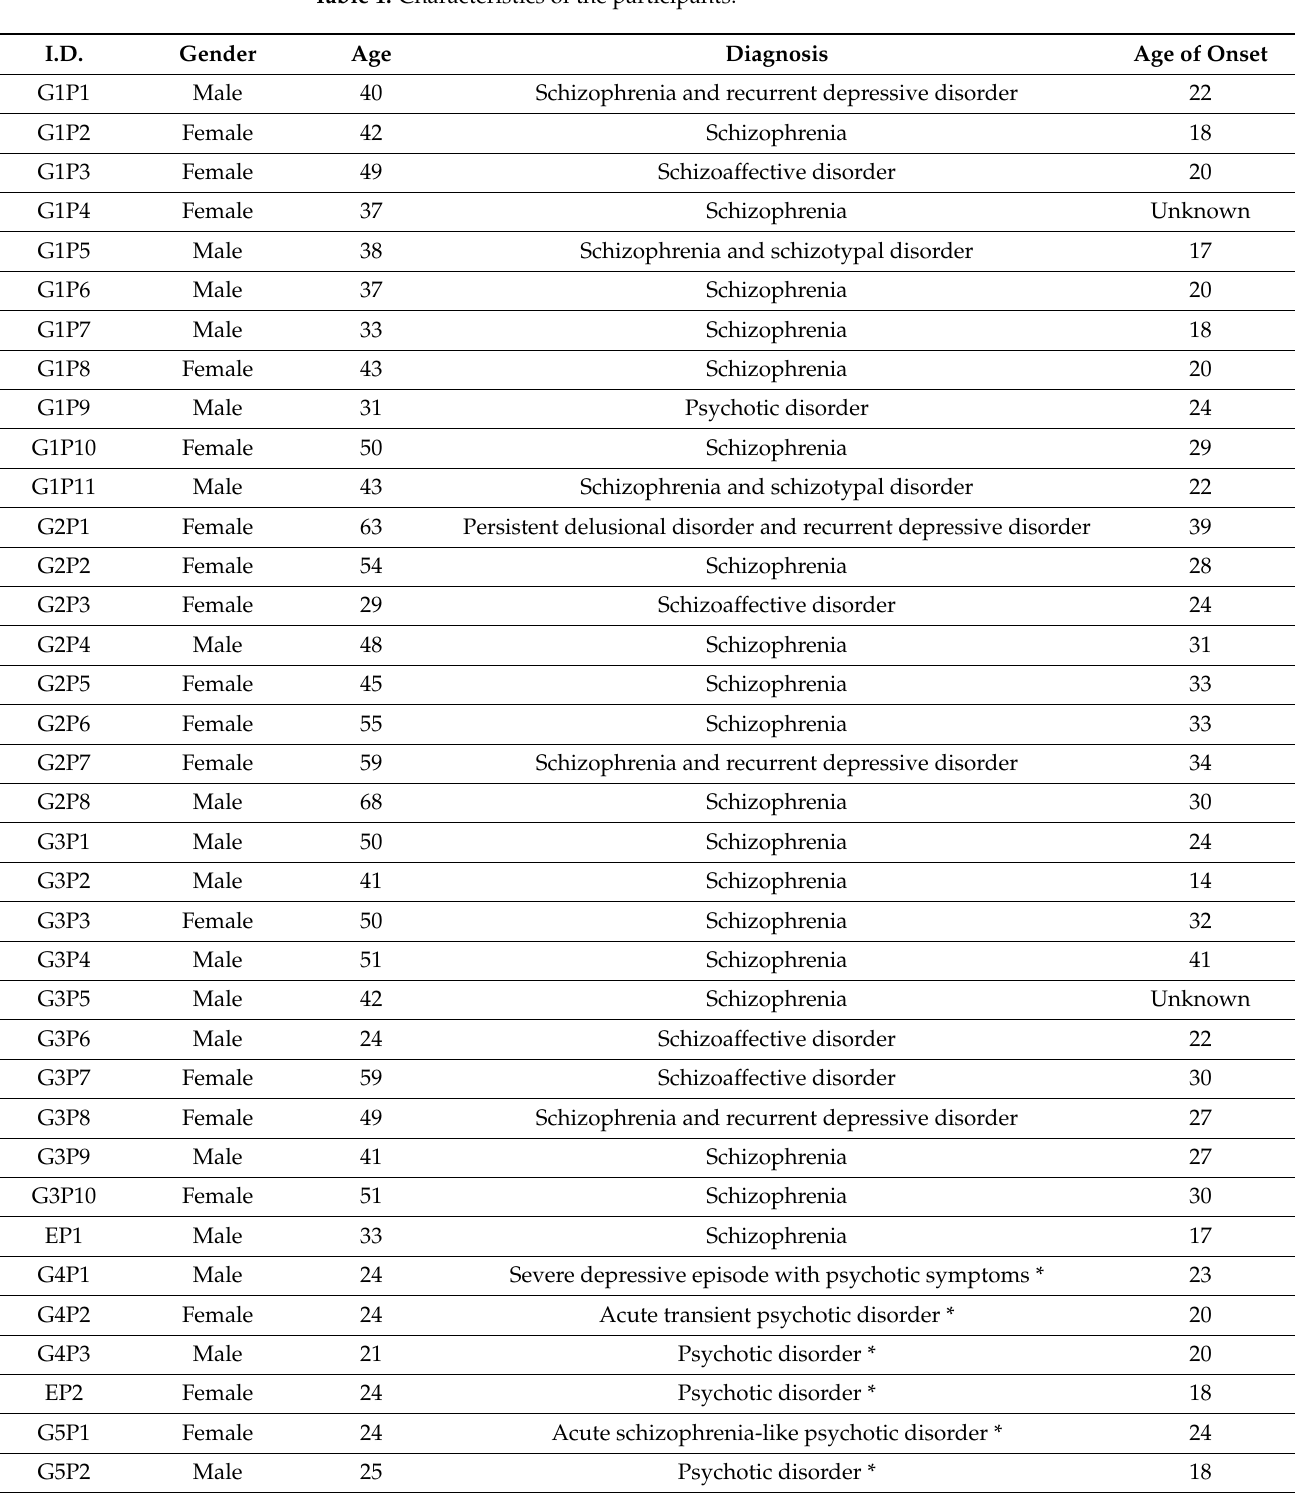
Table 1. Characteristics of the